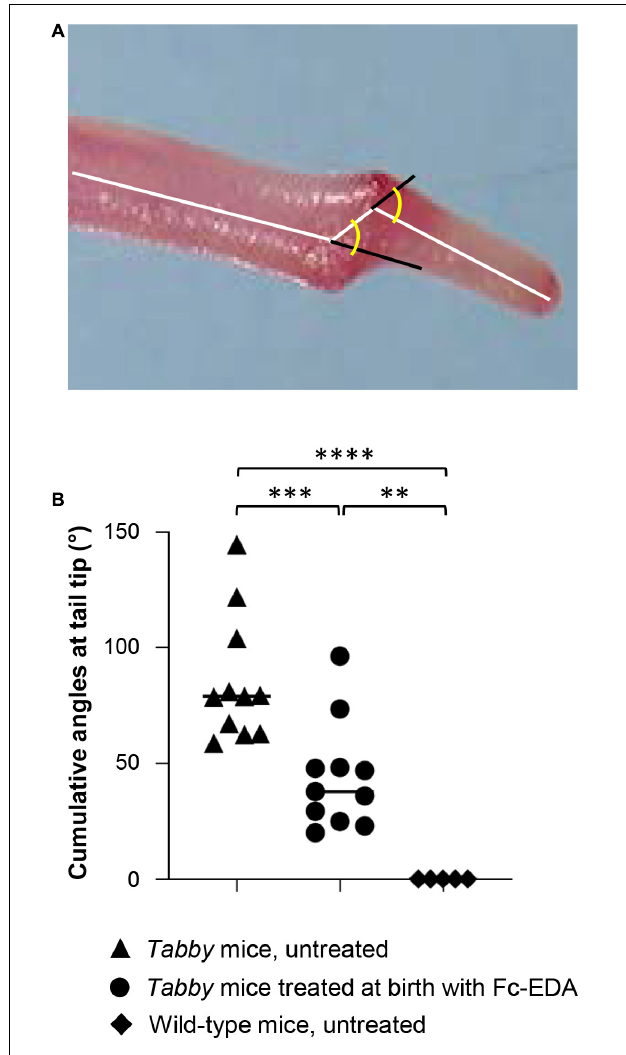
FIGURE 5 | Attenuation of the tail kink in Tabby mice upon postnatal treatment with EDA1. (A) Tabby mice were treated at birth with EDA1 (2 mg/kg body weight, intraperitoneal injection) and sacrificed at weaning. Pictures of the tails were taken for measurements. The amplitude of kink was quantified by the cumulative angles at the tail tip using ImageJ. (B) Cumulative angles ( ◦ ) of the tail tips of untreated Tabby mice ( n = 11; black triangles), Tabby mice treated at birth with EDA1 ( n = 11; black circles) and untreated wild-type mice ( n = 5; black squares). Data are shown as mean ± SD; ∗∗ p = 0.001–0.01; ∗∗∗ p = 0.0001–0.001; ∗∗∗∗ p <